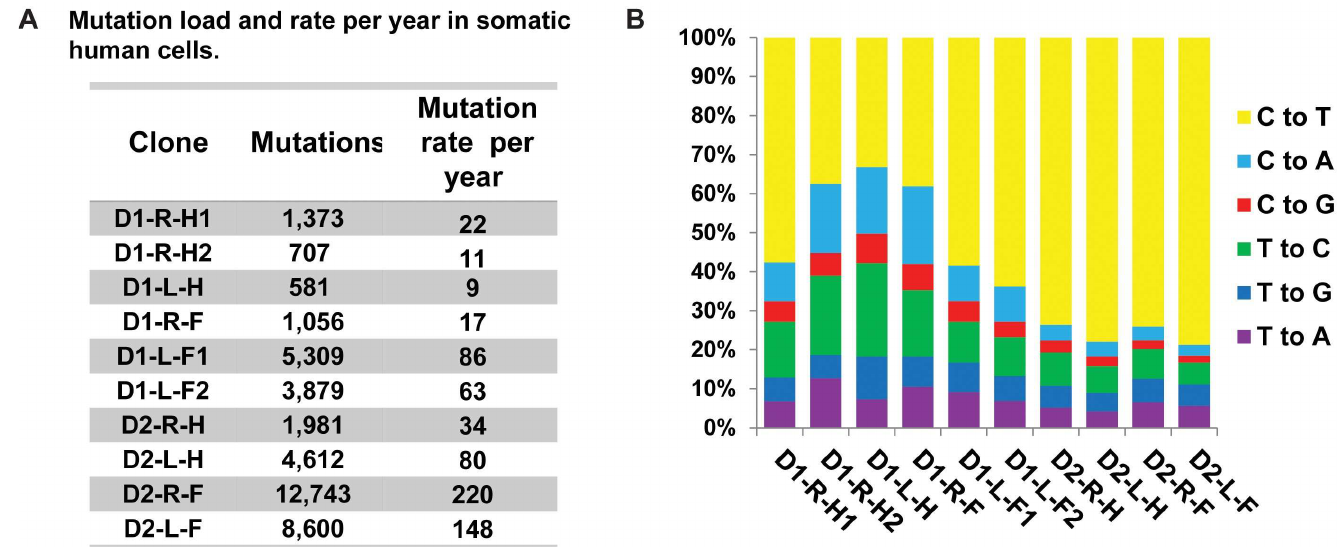
Fig 3. Somatic mutation load and spectra in the fibroblast clones. (A) The number of somatic mutations detected in each clone and the rate of accumulation of mutations per year are provided. (B) The spectra of base changes in the clones. For each base change the reverse complements are also